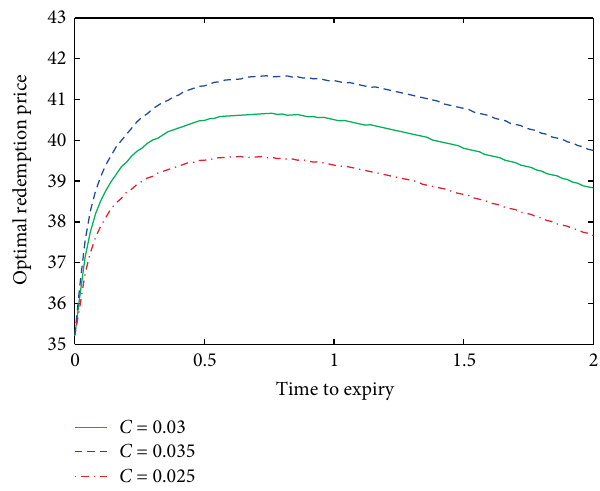
Figure 6: Optimal redemption prices with 𝐺 = 1.2, 𝑀 = 1, 𝑌 = 1.5, 𝑇 = 2, 𝐾 = 50